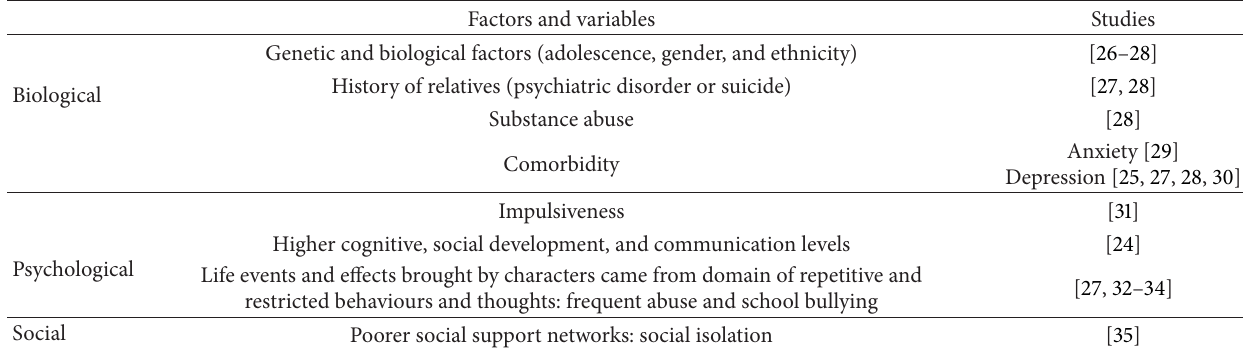
Table 2: Overview of factors of risk for suicide in Autism Spectrum Disorder (ASD). Most vulnerable population with ASD (modified from [24,